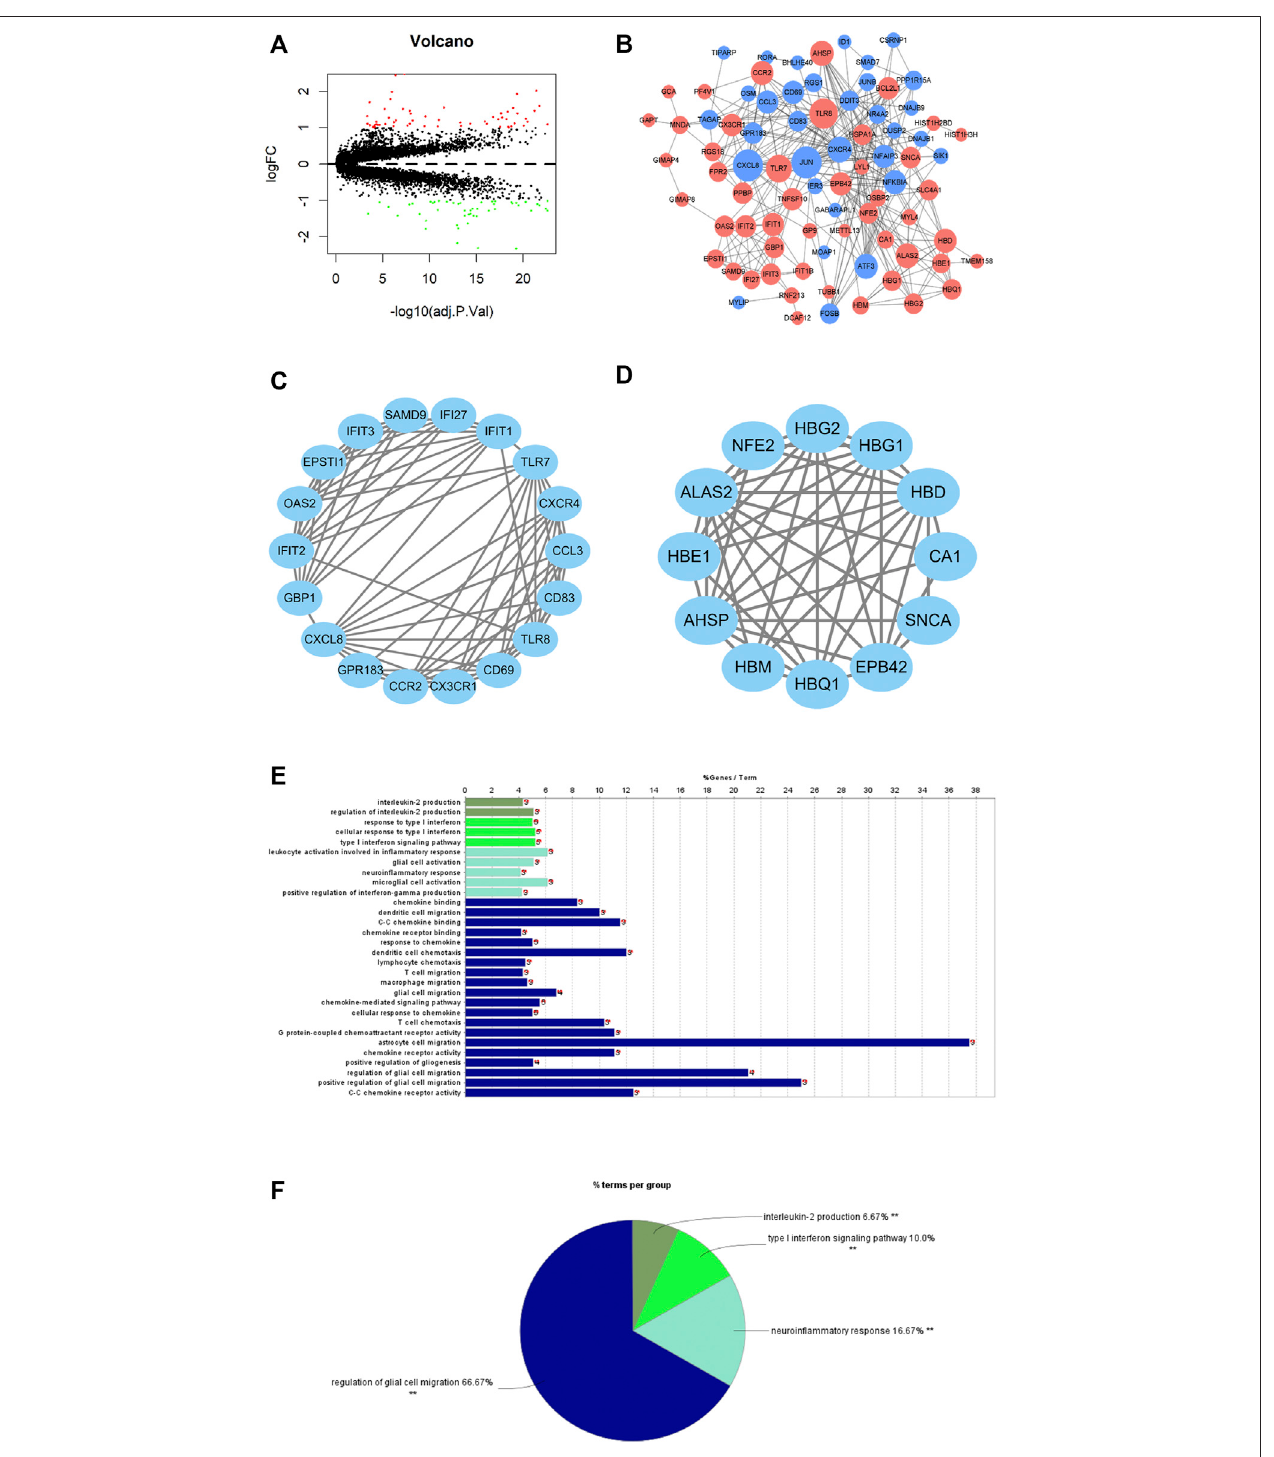
FIGURE 2 | DEGs of PAH patients and DEG functional annotation and enrichment analyses. (A) Volcano plot of differential expression analysis of PAH samples relative to healthy samples (red dots: signi fi cantly highly expressed genes; green dots: signi fi cantly lowly expressed genes). (B) PPI network based on PAH DEGs (red nodes: differentially upregulatedgenes; blue nodes: differentially downregulatedgenes); node sizerepresents connectivityofthisgene inthePPInetwork.Thelargerthe node, the higher is the connectivity, and the smaller the node, the less is the connectivity. (C,D) The major function modules in the PPI network; (E,F) GO function enrichment analysis for the genes in the top one major function module.